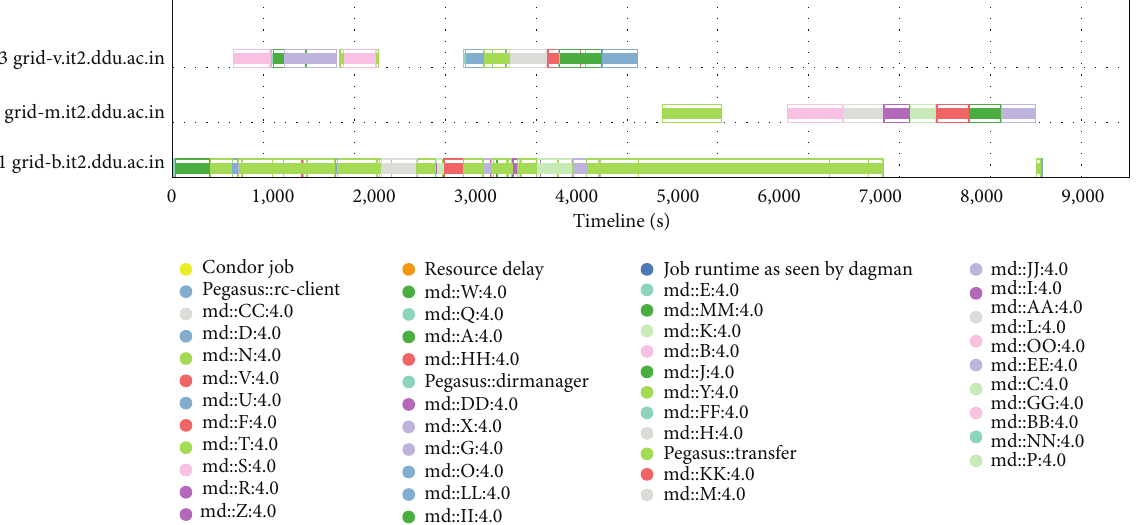
Condor job Resource delay